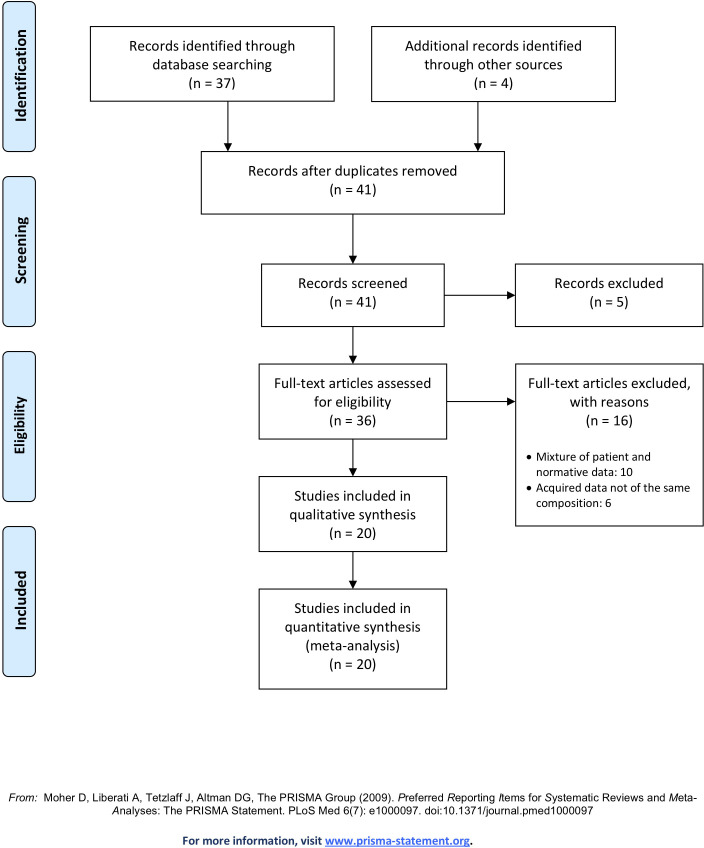
PRISMA flow diagram.